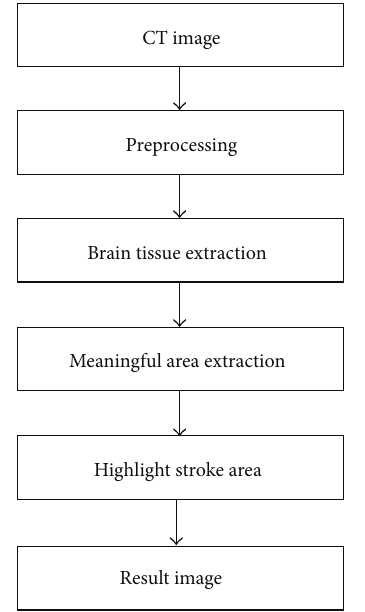
Figure 1: System flowchart for ischemic stroke